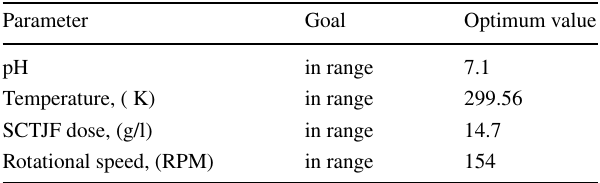
Table 9 Optimum values depending upon input operating parameters